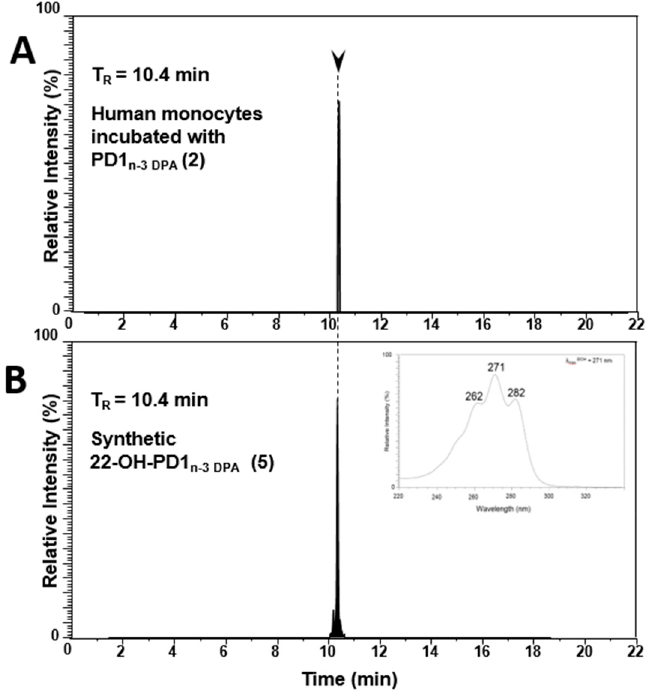
Figure 5. PD1 n-3 DPA ( 2 ) was converted to 22-OH-PD1 n-3 DPA ( 5 ) by human monocytes. Multiple reaction monitoring chromatograms for m / z 377 > 361 of the products obtained from ( A ) human monocytes incubated with PD1 n-3 DPA ; ( B ) synthetic 22-OH-PD1 n-3 DPA .